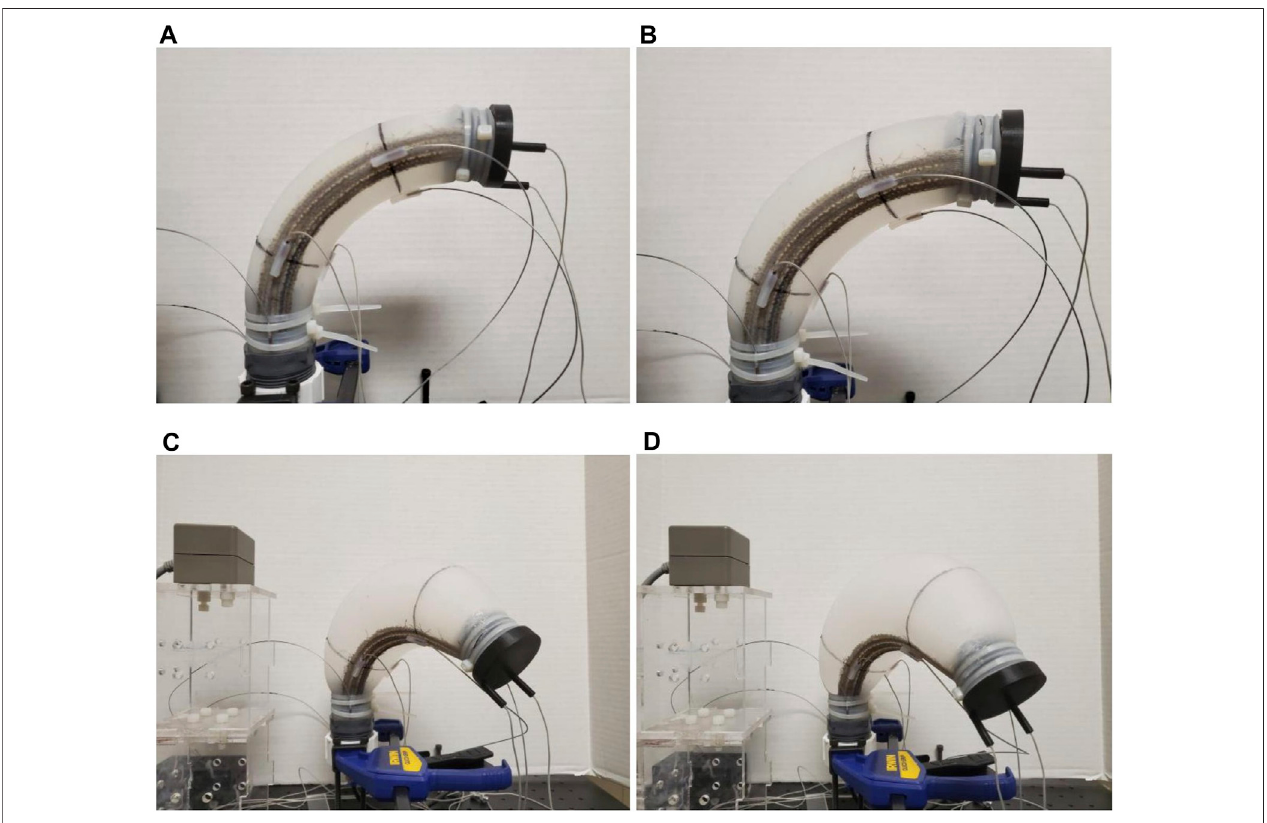
FIGURE1| Theposesofthefabric-reinforcedin fl atablesoftrobotatfourdifferentpressures, (A) At1.5 psi, (B) at2.5 psi, (C) at3 psi, (D) at3.5 psi[Reprintedfrom (Bui and Schultz, 2021) with permissions].